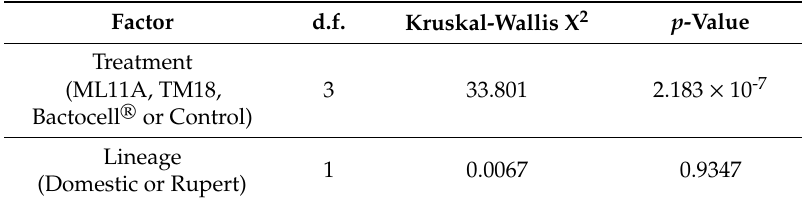
Table 6. Kruskal-Wallis rank sum test of blood plasma lysozyme activity, with either Treatment or Lineage as explanatory